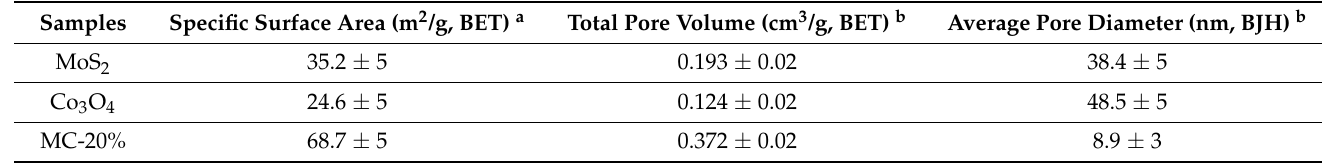
Figure 4. The surface chemical station analysis of MC-20%, ( a ) Survey spectra, High resolution XPS spectra of ( b ) Mo 3d spectra, ( c ) S 2p spectra, ( d ) Co 2p spectra, and ( e ) O 1s spectra, ( f ) EDS analysis of MC-20% nanohybrids. Table 1. The physical adsorption parameters of the photocatalysts of MoS 2 , Co 3 O 4 , and MC-20% were measured three times.